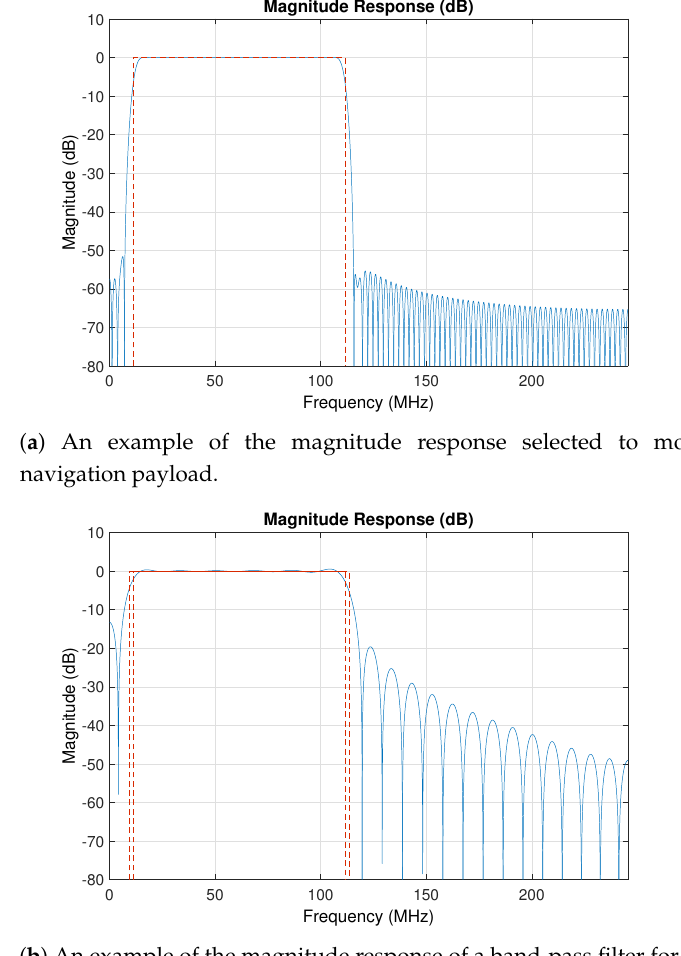
Figure 6. Examples of characteristics of the band-pass filter at the transmitter for a genuine ( a ) and spoofer ( b )